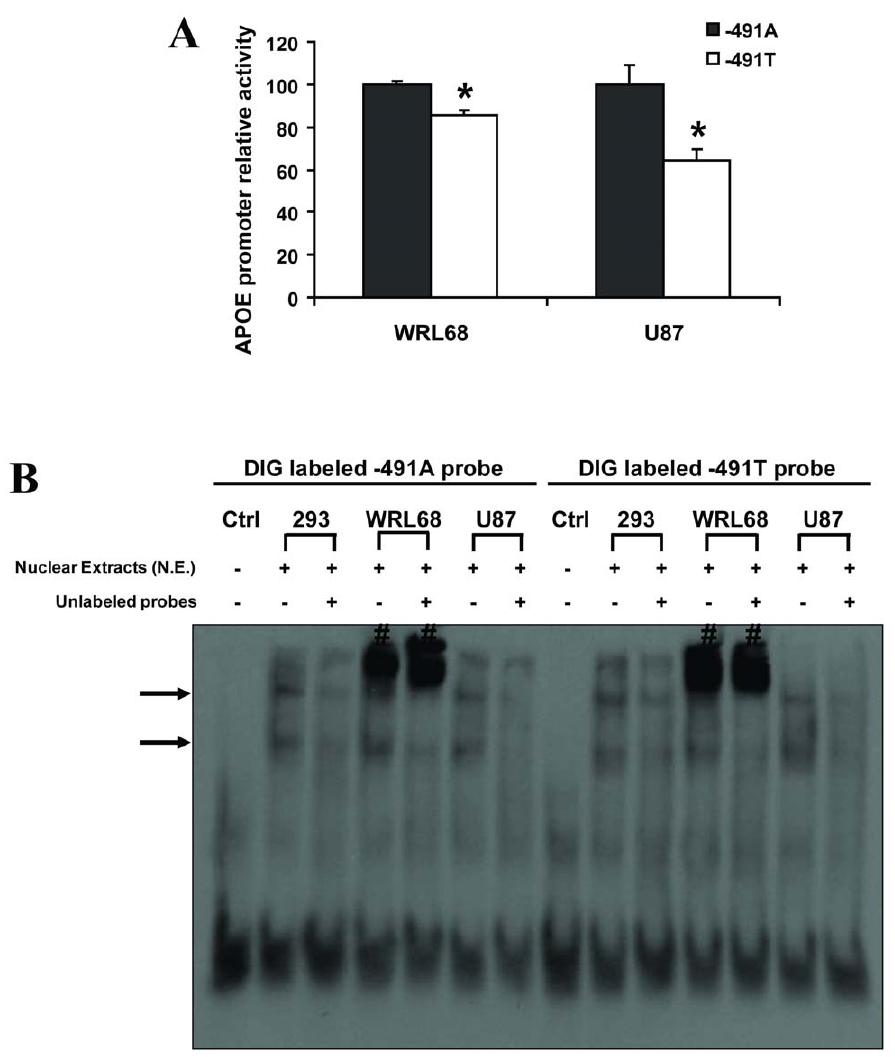
Figure 1. APOE promoter 2 491A/T polymorphism is a functional variant. (A) 2 491A to T single nucleotide substitution significantly decreases the transcriptional activity of the APOE promoter. APOE promoter firefly luciferase reporter constructs ( 2 1017 to + 406) containing A or T at 2 491 site are designated 2 491A or 2 491T, respectively. Data are presented as APOE promoter ( 2 491T) activity relative to that of its 2 491A counterpart (value set at 100%). Data are obtained from three to five independent experiments in triplicate set up. * p , 0.05 by Student’s t -test. (B) Interaction between nuclear factors and APOE promoter 2 491A/T-spanning sequence. EMSA assays were performed in 20 m l reaction system containing 3 nM of DIG-labeled 2 491A or 2 491T probe ( 2 521 to 2 461) 6 5 m g of cell nuclear extracts. The absence ( 2 ) or the presence ( + ) of 192 nM of unlabeled corresponding 2 491A or 2 491T probes served as the control or competition conditions for specific binding between the DIG- labeled probe and nuclear proteins. Shift-bands are indicated by arrowheads. Non-specific shift-bands are indicated by ‘‘ # ’’. WRL68: human hepatic embryonic cell line; U87: human astrocytic cell line; 293: human kidney epithelial cell line.